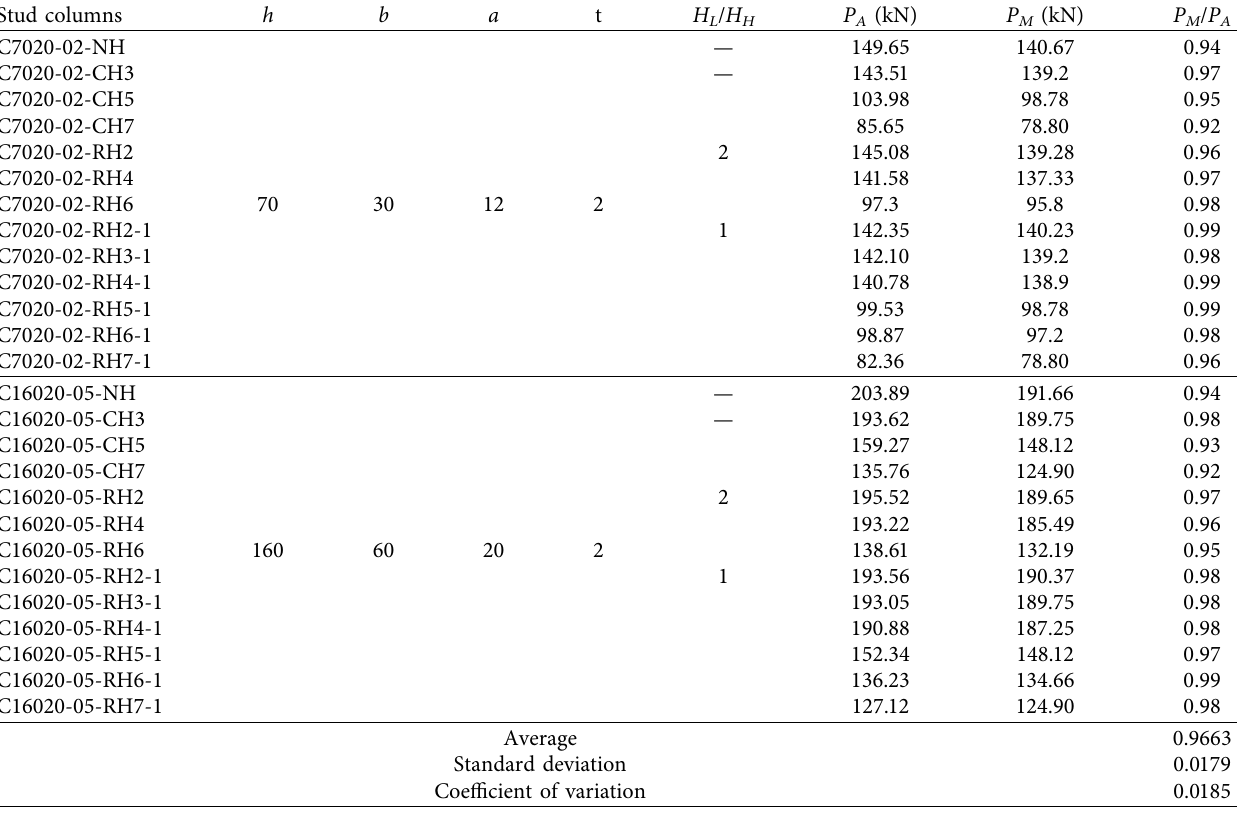
Table 5: Ultimate strengths of section C7020-02 series and section C16020-05 series by using FEA and the modified EWM. Stud